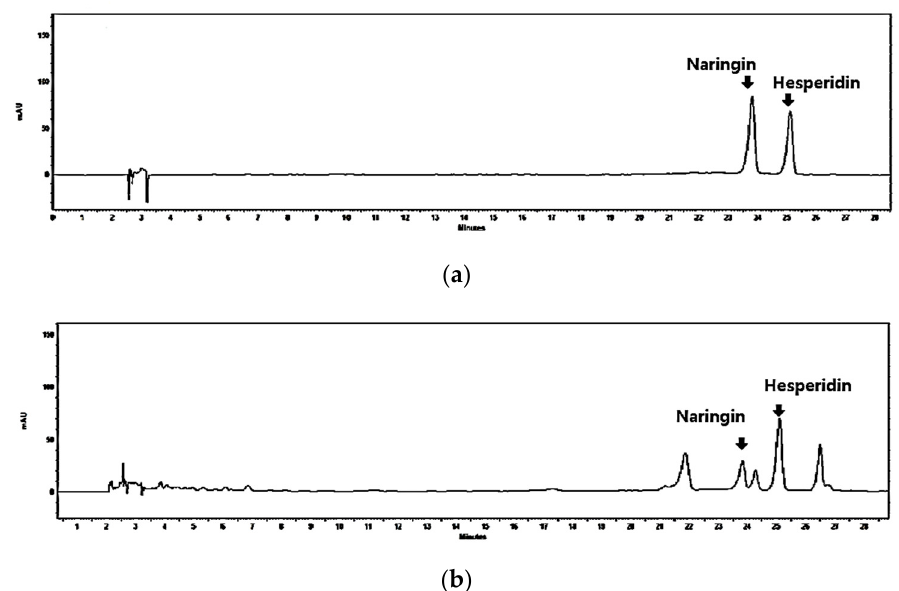
Figure 1. Quantification of naringin and hesperidin from CJBs. Representative high-performance liquid chromatography chromatogram (at 280 nm) of the ( a ) naringin and hesperidin reference standard and ( b ) CJBs. The arrowed peak has been identified as naringin and hesperidin.